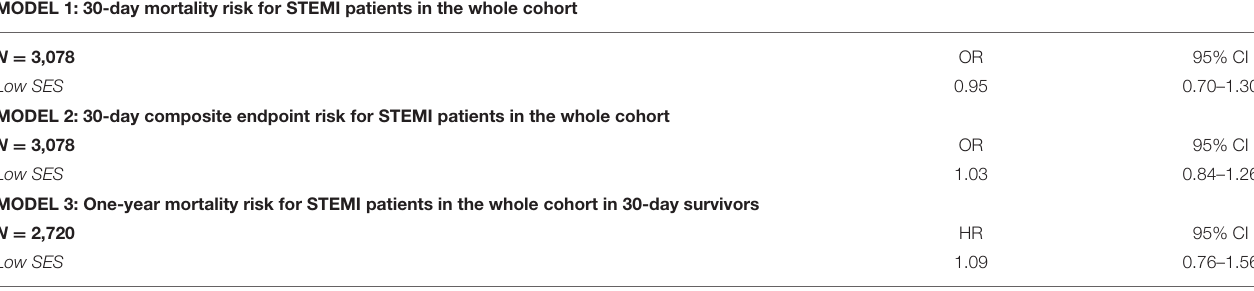
TABLE 4 | Low-SES patients with ST-elevation myocardial infarction (STEMI) adjusted odds ratio (OR) of 30-day mortality (model 1); a 30-day composite end point (death, ventricular fibrillation, acute pulmonary edema, or cardiogenic shock) (model 2); and hazard ratio (HR) of 1-year mortality in 30-day survivors (model 3) in the “Codi IAM” network during the 2010-2016 period. MODEL 1: 30-day mortality risk for STEMI patients in the whole cohort